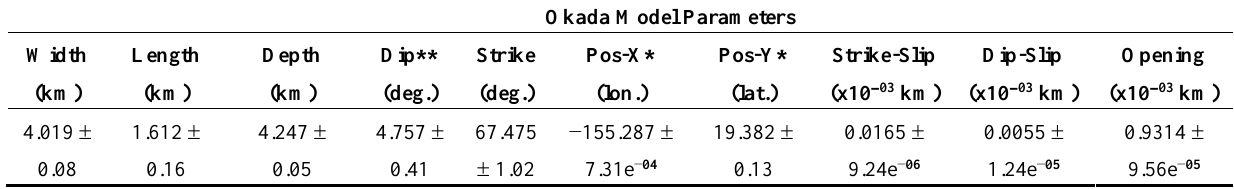
* The ground coordinates at the origin (top left-hand corner) of the X and Y axes are −155.35208º and 19.44708º, respectively. ** The angle between the model and a horizontal plane (0 to